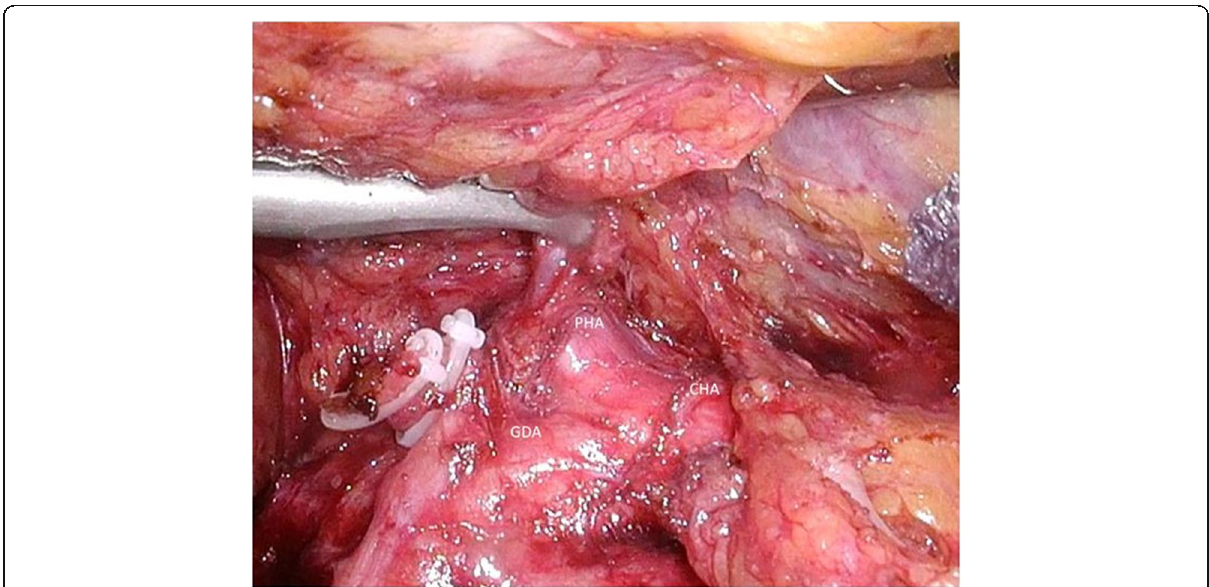
Fig. 5 After exposing the PHA by dissection of consecutive layers, both the GDA and the CHA, a pedicle of the RGA was divided safely. PHA, proper hepatic artery; GDA, gastroduodenal artery; CHA, common hepatic artery; RGA, right gastric